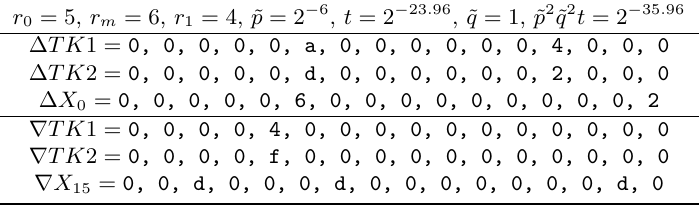
Table 22: The 15-round related-tweakey boomerang distinguisher for SKINNY-64-128 .